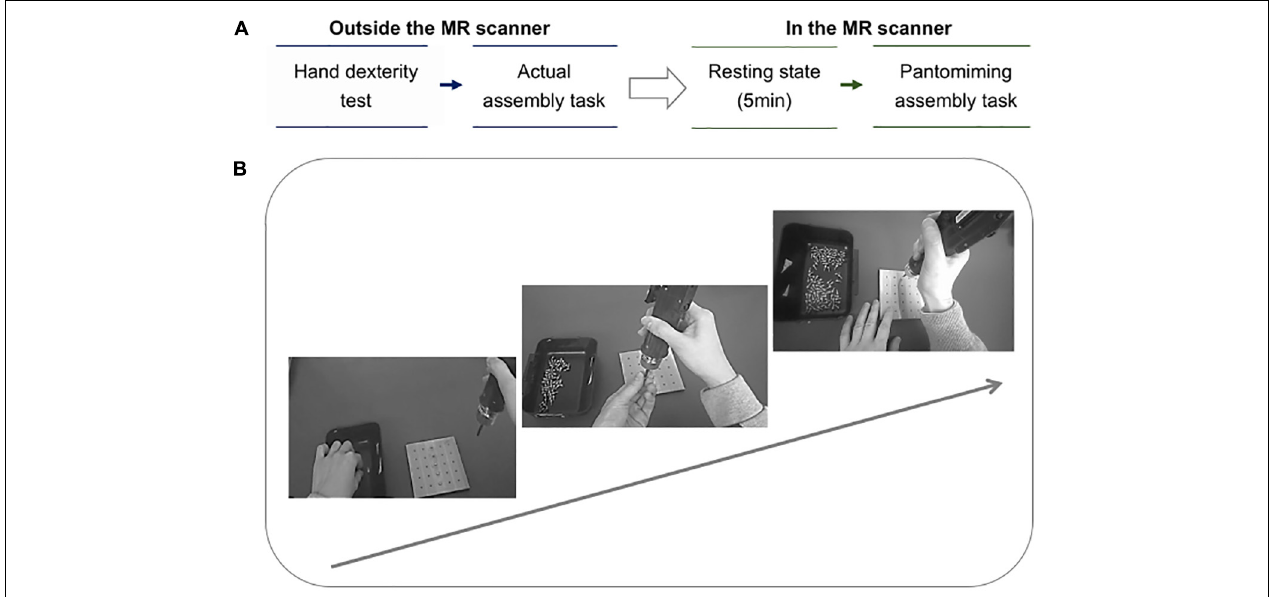
FIGURE 1 | (A) Protocol summary. The arrow indicates the order of the tasks, from outside the MR scanner to inside the MR scanner. There are two phases in the protocol: (1) two tests were conducted outside the MR scanner. First, the participants performed the manual hand dexterity test using the Purdue Pegboard Test, and then they underwent the actual assembly task. (2) Imaging using the MR scanner. Second, the participants underwent resting-state fMRI for 5 min. Thereafter, an fMRI scan was executed as the participants were instructed to pantomime the assembly task while viewing their own performance. (B) Assembly task process. The arrow indicates the workflow of the assembly task. The participants were instructed to pick up a screw from the basket on the left with their left hand and attach it to the tip of the device, then insert the point of the screw into the hole of the square base. Finally, the thumb of the right hand was used to push the button on the handle of the device for tightening the screw. This process was repeated from the top hole of the base to the sixth